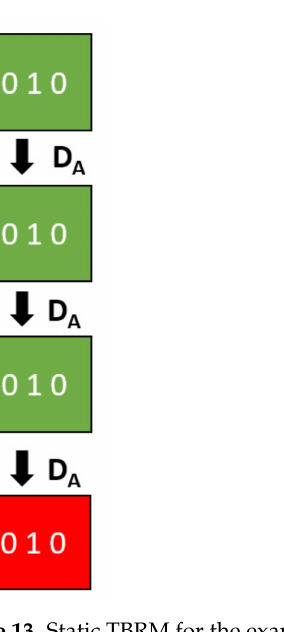
Figure 13. Static TBRM for the example task in a MAS not implementing the ITM.